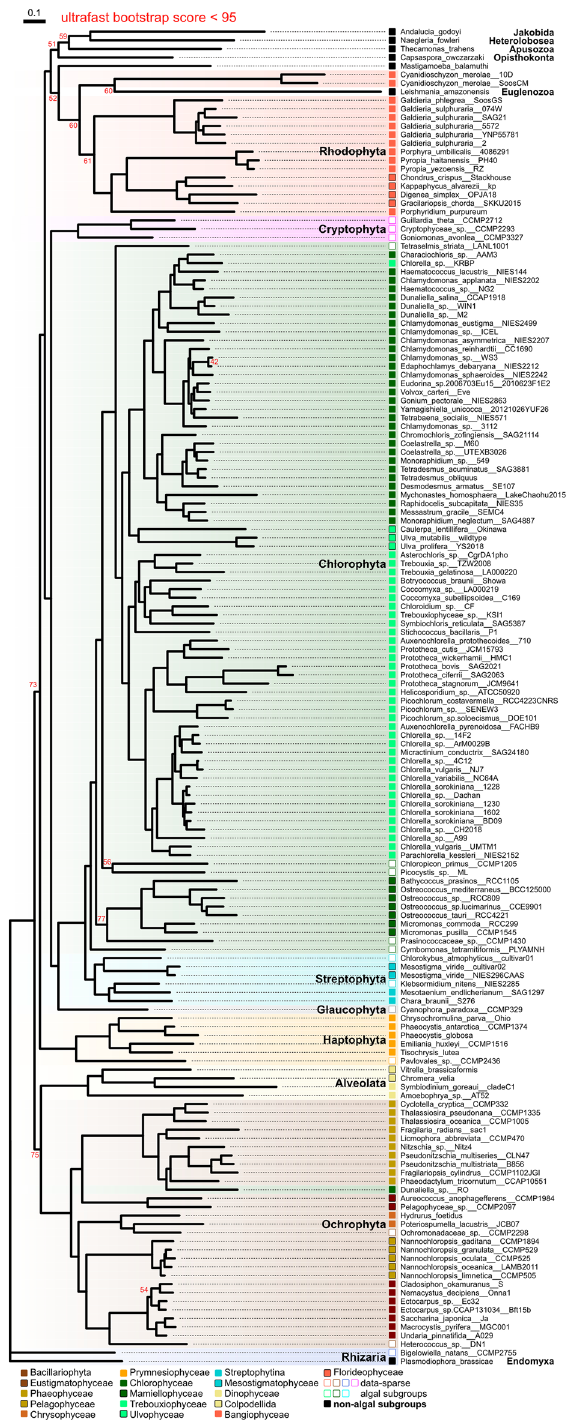
Figure 5. Maximum-likelihood tree reconstructed using 67 eukaryota_odb10 genes. Ultrafast bootstrap supports of 95% or more were omitted. Otherwise, bootstrap supports are denoted by nodes. Taxonomic groups are indicated by shaded rectangles. Taxonomic subgroups are indicated by a colored